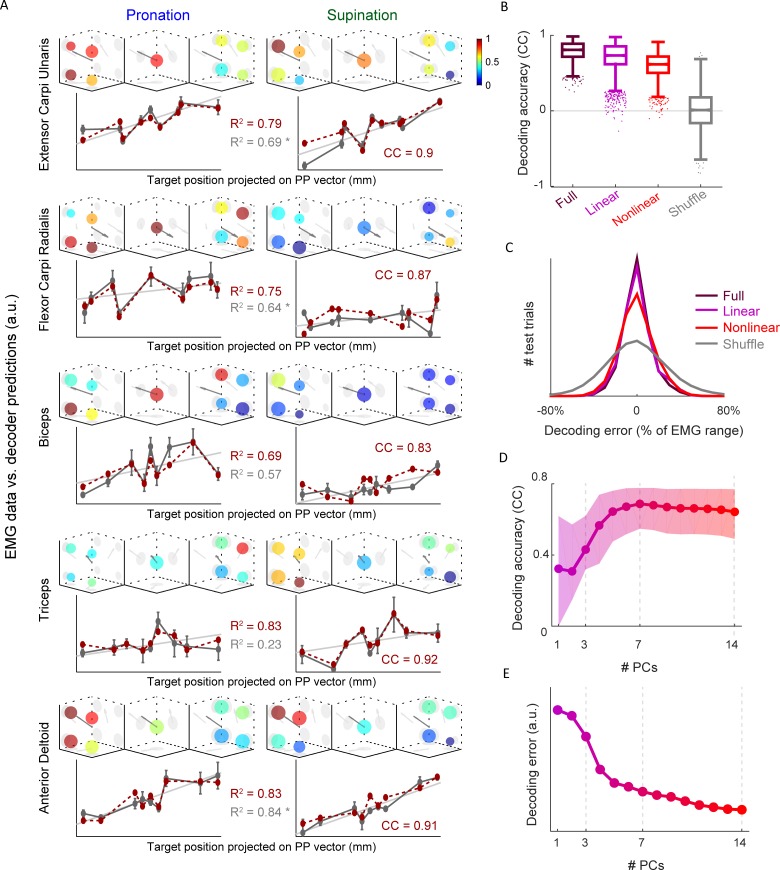
A. EMG as function of arm posture in same format as the neuronal responses (Fig 2). EMGs were fit to the extended linear tuning-curve (Methods, Eq 3), the PP vector in 3D plots, gray line in 2D plots, and R2 in gray, reflect this fit. Dotted red line shows EMG values predicted by linear decoder on held-out test data from one repetition of cross-validation, with its R2 and correlation coefficient in red. B. Distributions of decoding correlation coefficients between predicted and real EMG values for the test trials of each cross-validation, over all muscles. Box plot shows median, 25% and 75% percentiles, whiskers cover ~ 99% of distribution, dots are outliers. Decomposition of responses into linear and nonlinear datasets described in text (and S3D Fig). C. Distributions of decoding errors (real EMG minus predicted) for all test trials and all muscles. The Linear and Full datasets’ curves partially overlap. D. Decoding correlation coefficients, like in B., as a function of number of PCs that data is projected on to. PCs were learned on training data only, and normalized and trial-averaged before PCA. E. Same as D., for S.D. of decoding error.